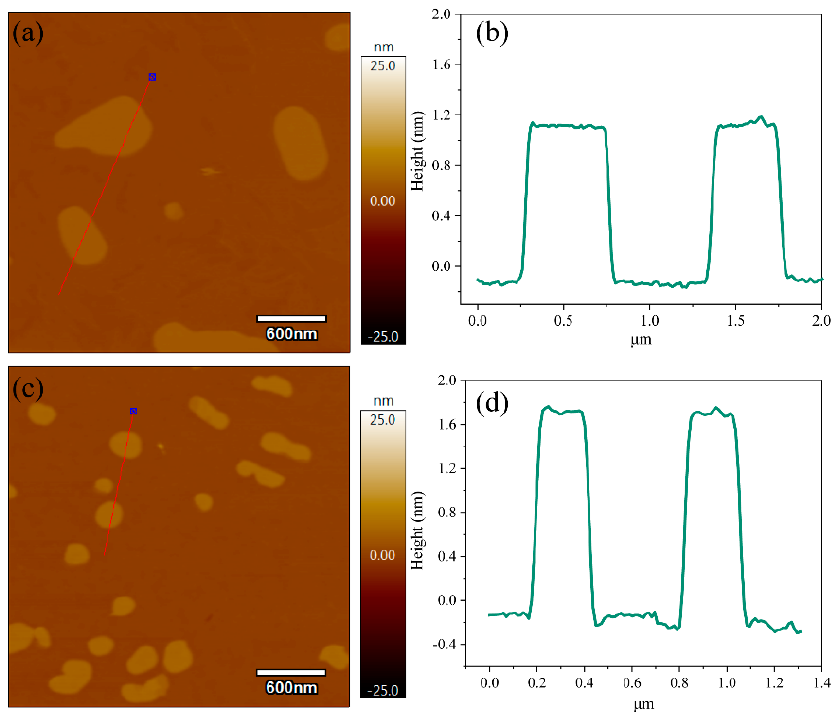
Figure 2. AFM image and height profiles of GO ( a , b ) and KH560-GO ( c , d ).